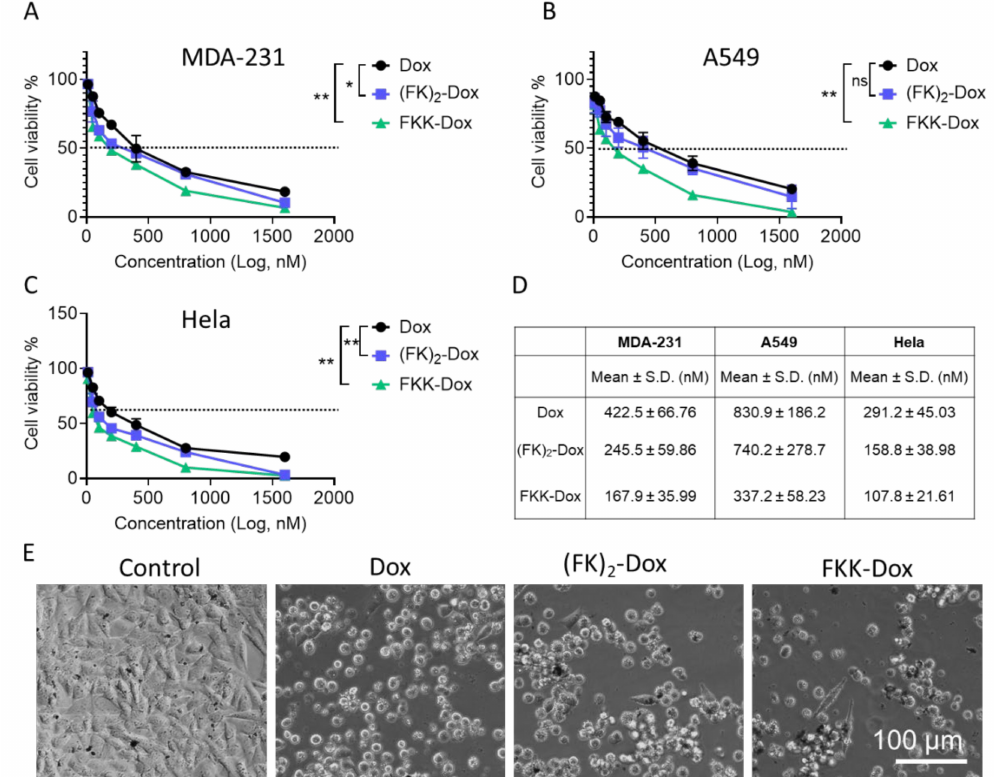
Figure 7. ( A – C ) Cell viability measurements for MDA-231, A549, and Hela cells treated with di ff erent concentrations of Dox, (FK) 2 -Dox or FKK-Dox. The values were measured at 2 days post-treatment of the Dox species. Three independent replications were performed. P values were determined by a repeated measures (RM) two-way analysis of variance (ANOVA) with Tukey’s multiple-comparisons test. ** P < 0.01; * P < 0.05. ( D ) Calculated IC 50 values of di ff erent Dox species to inhibit the cancer cell growth. ( E ) The optical view of a Hela cell morphology after treated with Dox (300 nM), (FK) 2 -Dox (300 nM of Dox), and FKK-Dox (300 nM of Dox) for 24 h; the cells without any treatment were